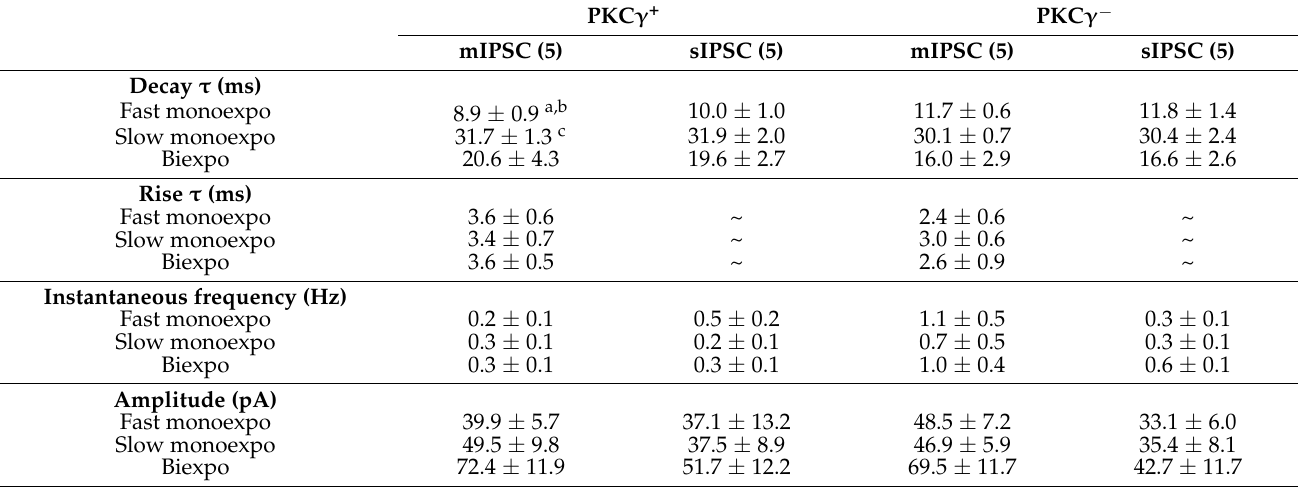
Table 3. Functional properties of mIPSC or sIPSCs recorded from lamina II i PKC γ + and PKC γ −